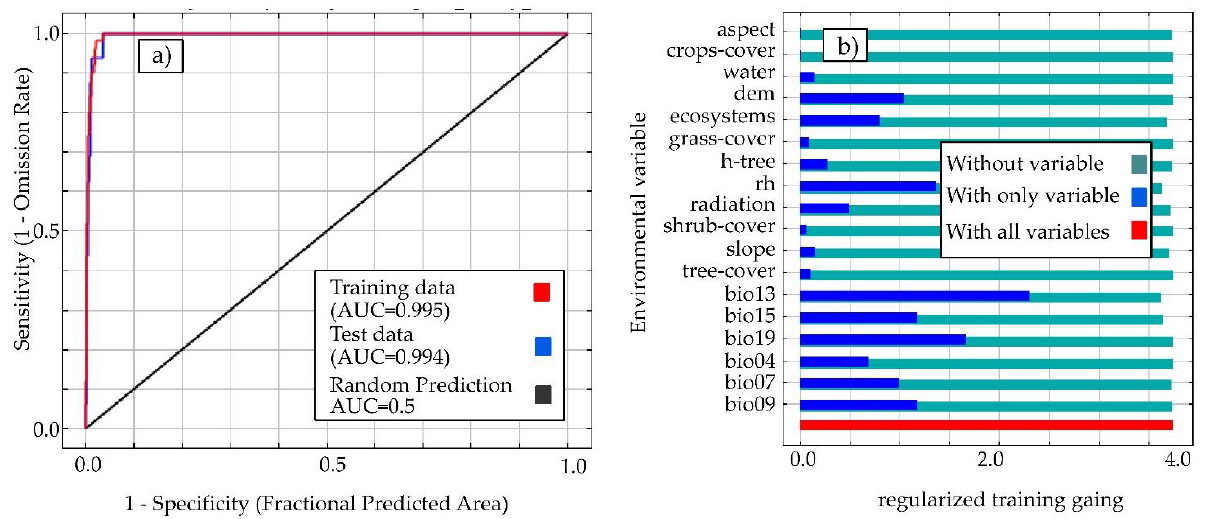
Figure 3. ( a ) ROC curve from the MaxEnt model. ( b ) The Jackknife test indicates the contribution of different environmental variables to the species’ current distribution.